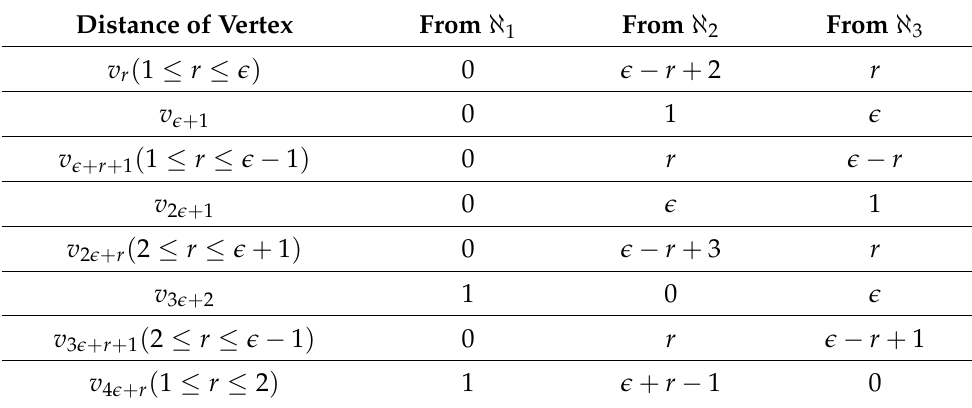
Table 7. Distance codes of V ( f α × 3 ) with respect to ℵ . Distance of Vertex From ℵ 1 From ℵ 2 From ℵ